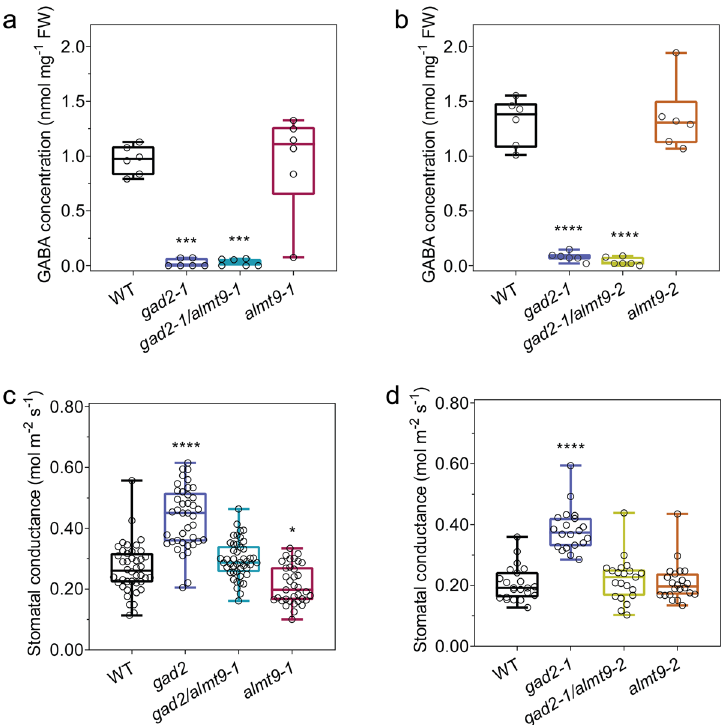
Fig. 6 The loss of ALMT9 suppresses the gad2 mutant stomatal phenotype. a – d Leaf GABA concentration ( a , b ) and stomatal conductance ( c , d ) of 5 – 6- week-old A. thaliana WT, gad2-1 , gad2-1/almt9-1 , almt9-1 , gad2-1/almt9-2 and almt9-2 plants; n = 6 plants ( a , b ); n = 42 for WT, n = 40 for gad2-1 , n = 45 for gad2-1/almt9-1 and n = 35 for almt9-1 , data collected from four independent batches of plants ( c ); n = 22 for WT, n = 20 for gad2-1 , n = 21 for gad2-1/ almt9-2 and n = 22 for almt9-2 , data collected from two independent batches of plants ( d ); data ( a , c ) were extracted respectively from Supplementary Fig. 13b, c. All data are plotted with box and whiskers plots: whiskers plot represents minimum and maximum values, and box plot represents second quartile, median and third quartile; statistical difference was determined by one-way ANOVA, * P < 0.05, ***P < 0.001 and ****P < 0.0001.